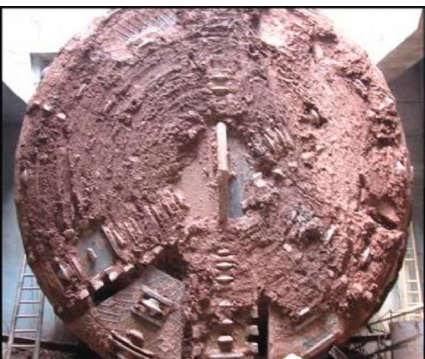
Figure 1: Squeezed muck wear in shield cutters, Guangzhou Metro